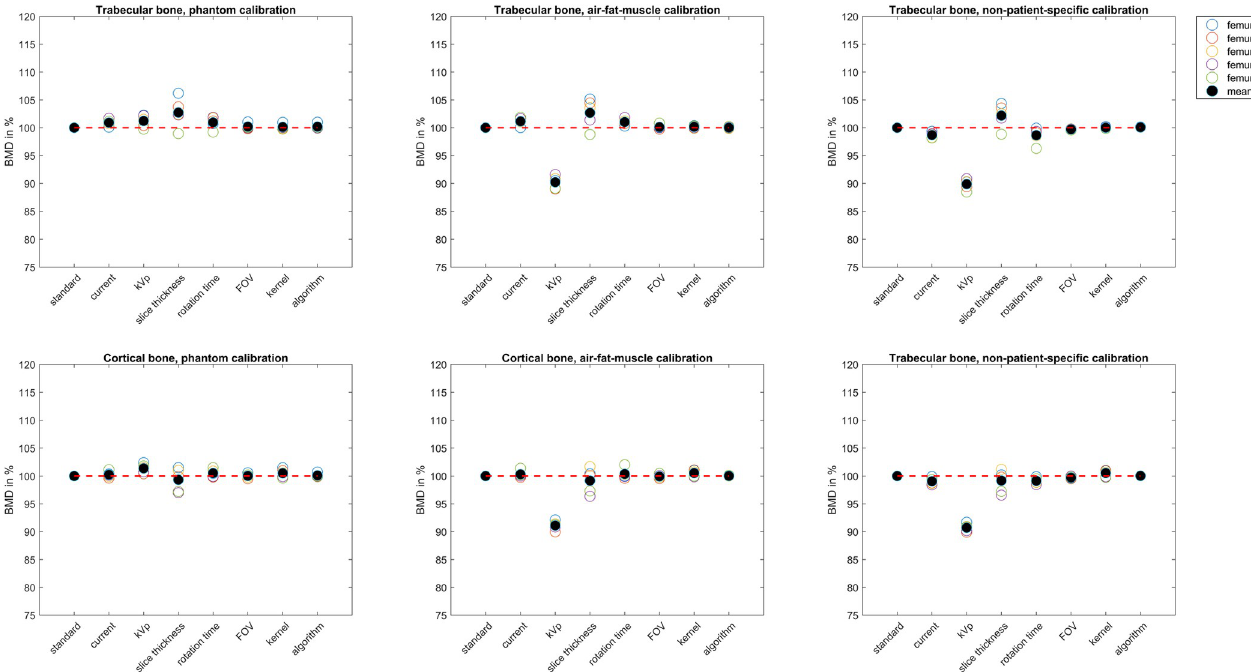
Fig 5. BMD of the trabecular (upper half) and cortical bone (lower half) for phantom (left), air-fat-muscle (middle), and non-patient-specific (right) calibration per protocol. For each femur, the BMD values are displayed relative to the standard protocol. The red dashed line indicates